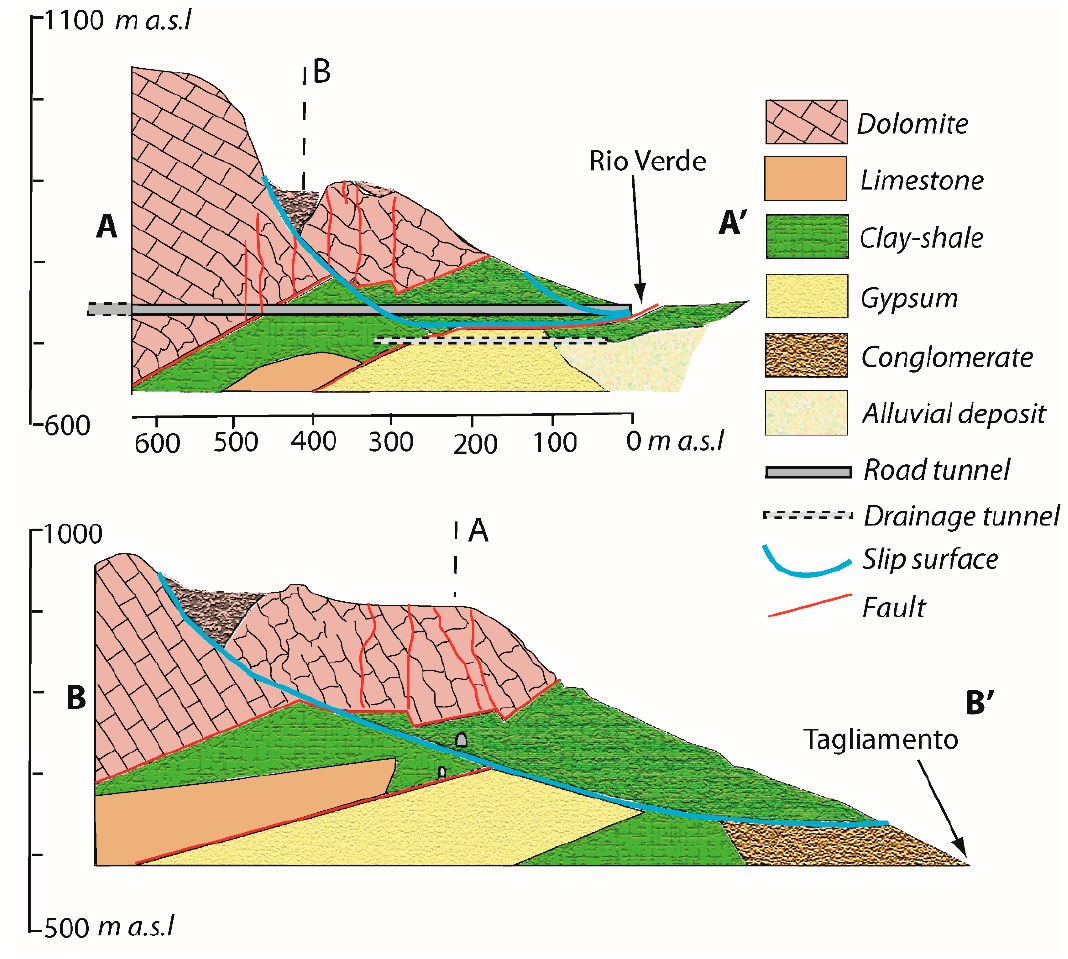
Figure 2. Geological section of the block slide.